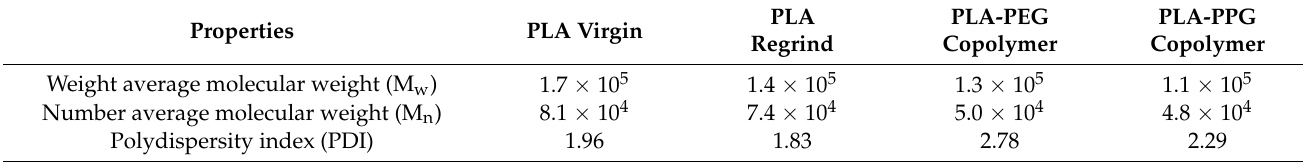
Table 1. Molecular parameters for the virgin PLA, PLA regrind, and PLA-based copolymers.